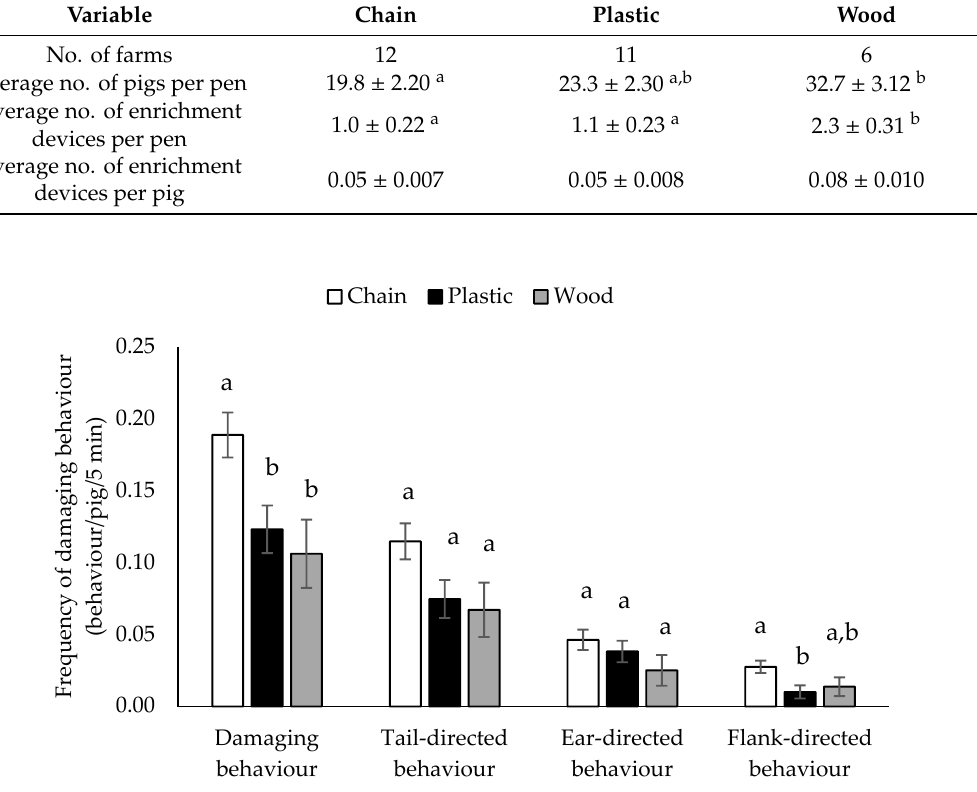
Figure 1. Frequency (LS means ± SE) of all damaging behaviours combined and tail-, ear-, and flank-directed behaviours observed during 5 min (behaviour / pig / 5 min) in finisher pigs on 29 farms that provided di ff erent types of enrichment (chains, plastic or wooden devices). Di ff erent superscript letters indicate significant di ff erences p < 0.05.